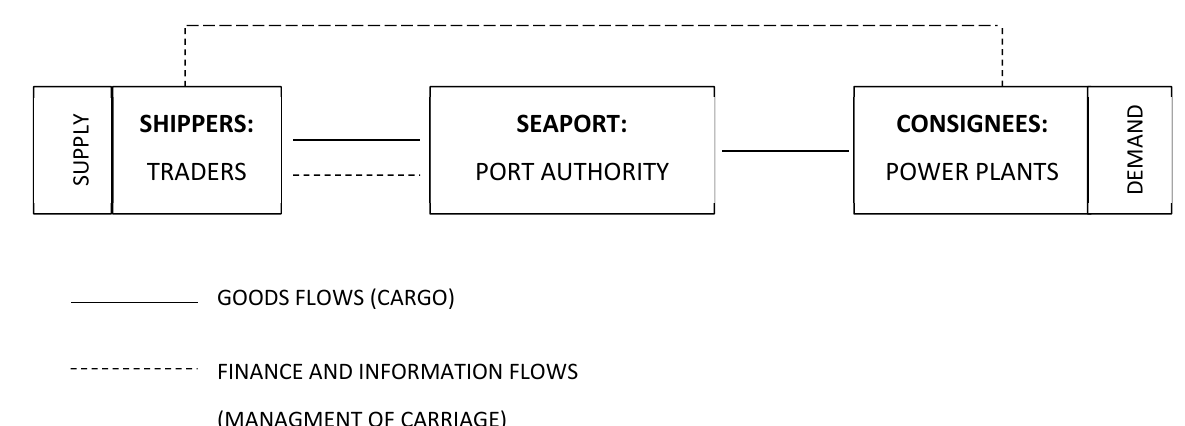
Figure 4. Relations between the examined stakeholders within the biomass sea-based supply chains.